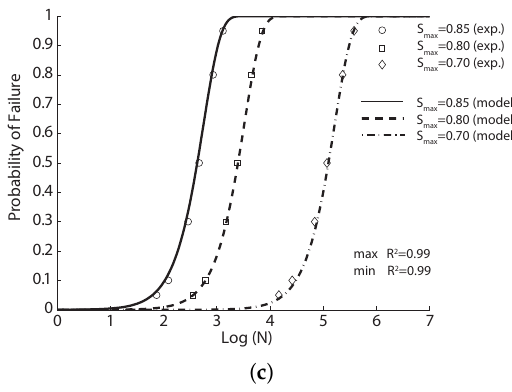
Figure 5. Comparison of the flexural fatigue data of Singh et al. [42] with the fitted probabilistic model Equation (8) for steel fiber-reinforced concrete (SFRC) with volume ratios of ( a ) 1%; ( b ) 1.5% and ( c ) 2%, with equal proportions of long and short fibers.